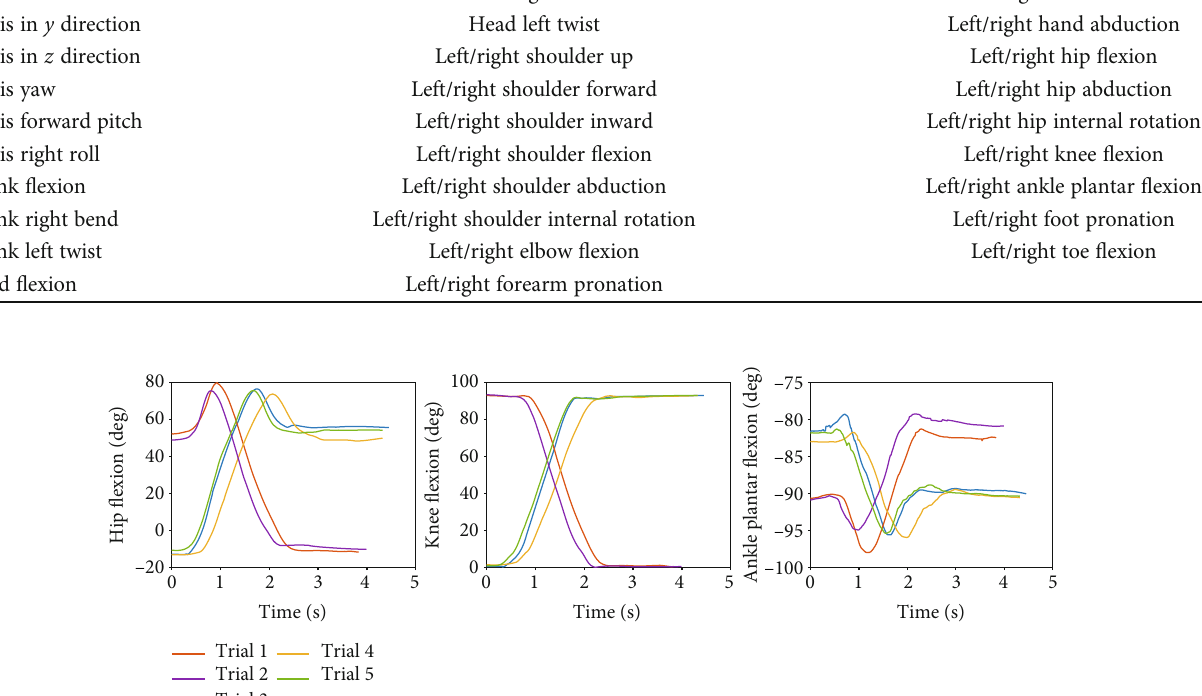
Table 7: This is a complete list of the kinematic and kinetic measurements that the reader can plot using the database and software at Fakoorian et al. [22]. There are a total of 46 kinematic and kinetic measurements that can be plotted for the full-body model. Pelvis in x direction